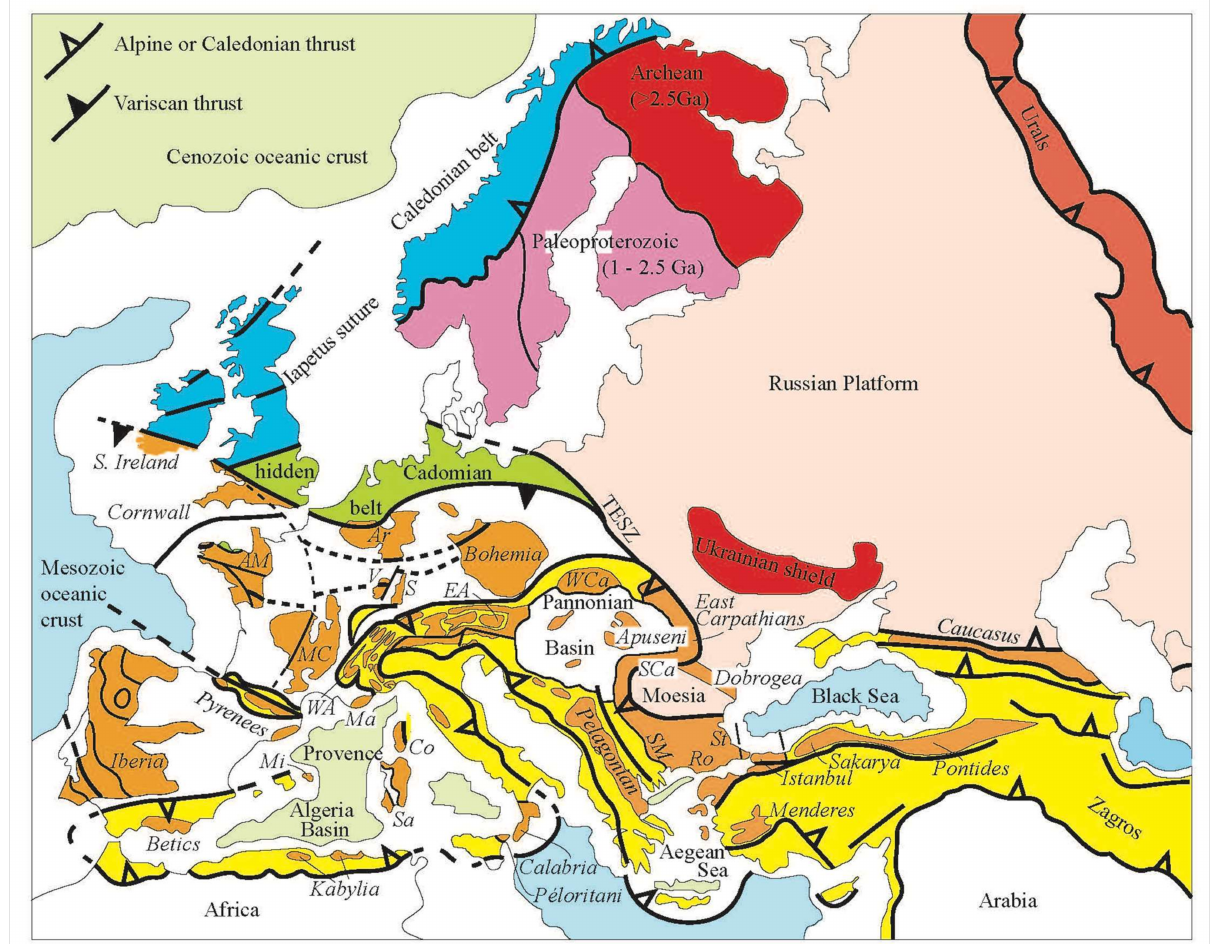
Figure 1. Tectonic map of Europa. The Variscan belt (in orange) occupies the medial part of the continent between the Early Paleozoic Caledonian belt (in blue) on northern Europa and the Cenozoic Alpine belt (in yellow) of southern Europa. The continuity of the Alpine belt is disrupted by the opening of the Neogene back-arc basins (in pale green). The Neoproterozoic Cadomian belt is hidden by younger formations or reworked in the Variscan belt. WA: Western Alps, EA: Eastern Alps,